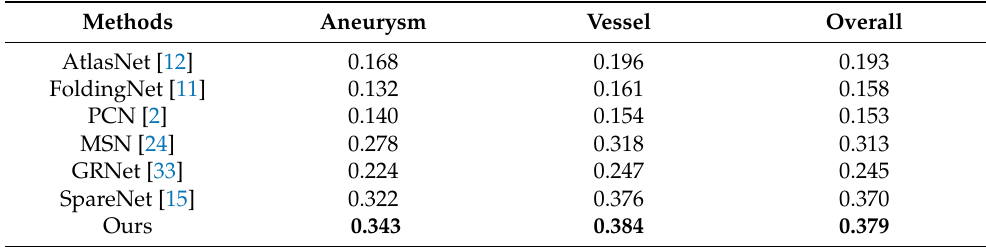
Table 1. Point completion results on IntrACompletion in F-score @1% (higher is better).